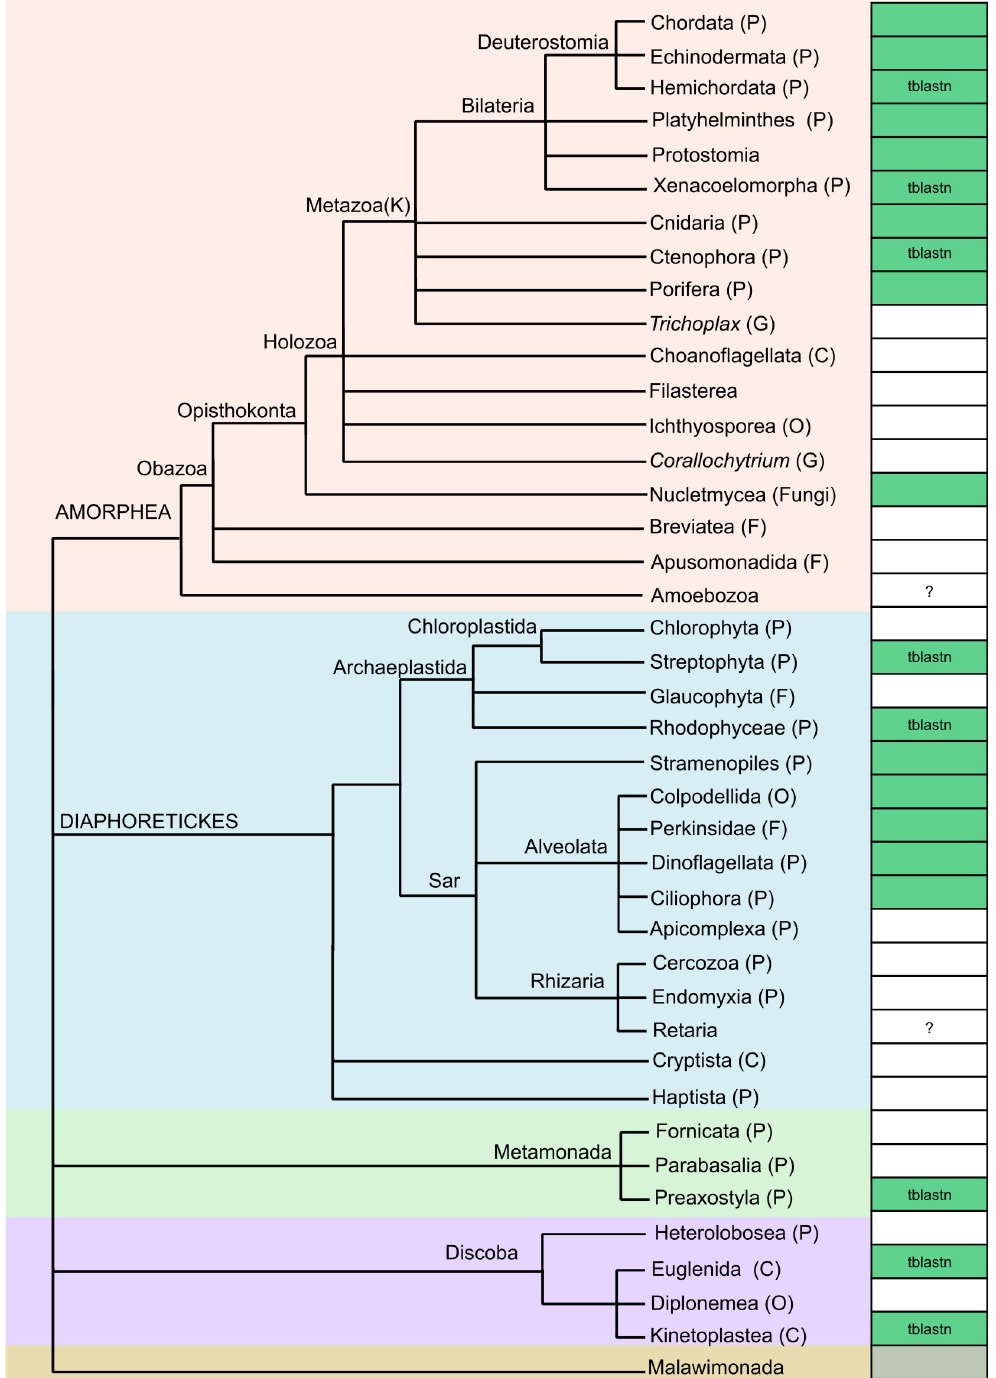
Fig 1. Phylogenetic distribution of the Merlin elements in eukaryotes. The cladogram was drawn based on [32], and the subdivisions of Bilateria followed the NCBI Taxonomy. Green boxes indicate the presence of Merlin in at least one species per each taxonomic group and those analyzed by tblastn were indicated; gray boxes indicate that the group has no genome sequence available; white boxes indicate that no Merlin sequence was found;? indicates that the presence of Merlin remains unclear. G = genus; F = family; O = order; C = class; P = phylum; K = kingdom. Some taxa that have no genome available were omitted from the three (Chaetognatha, Gnathostomulida, Syssomonas from Holozoa; Colponemidia, Acavomonas from Alveolata; Jacobida, Tsukubamonas from Discoba: Symbiontida from Euglenozoa).